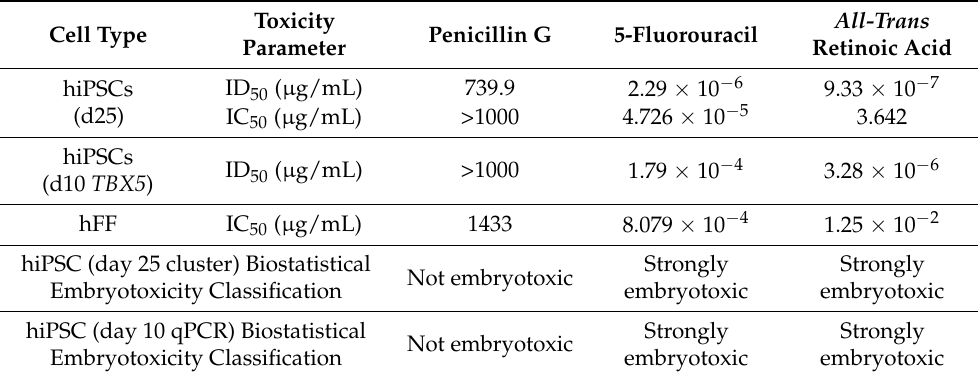
List of IC 50 and ID 50 values and embryotoxicity classifications determined from concentration-response curves for contractile and d10 qPCR assay endpoints. hiPSC, human induced pluripotent stem cell; hFF, human foreskin